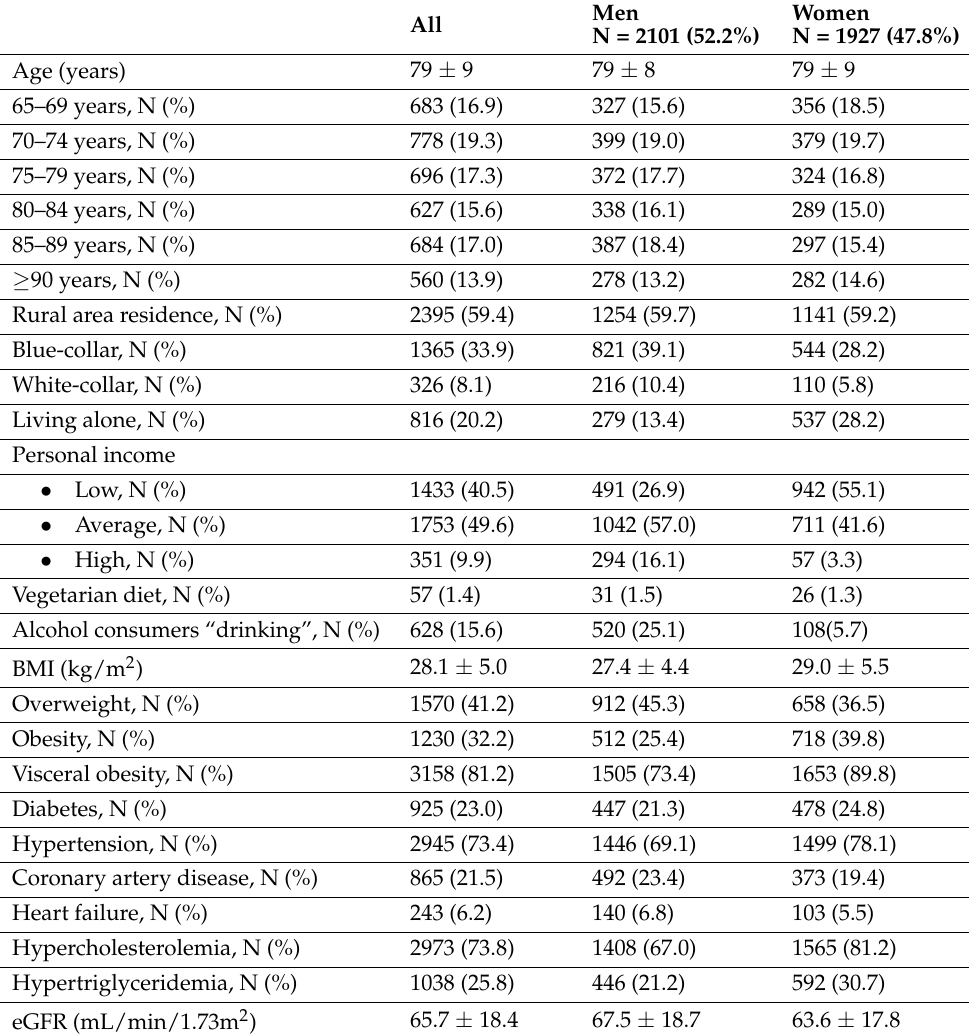
Table 1. Characteristics of the study group included in the analysis of hyperuricemia for all analyzed subjects (N = 4028), and for men and women